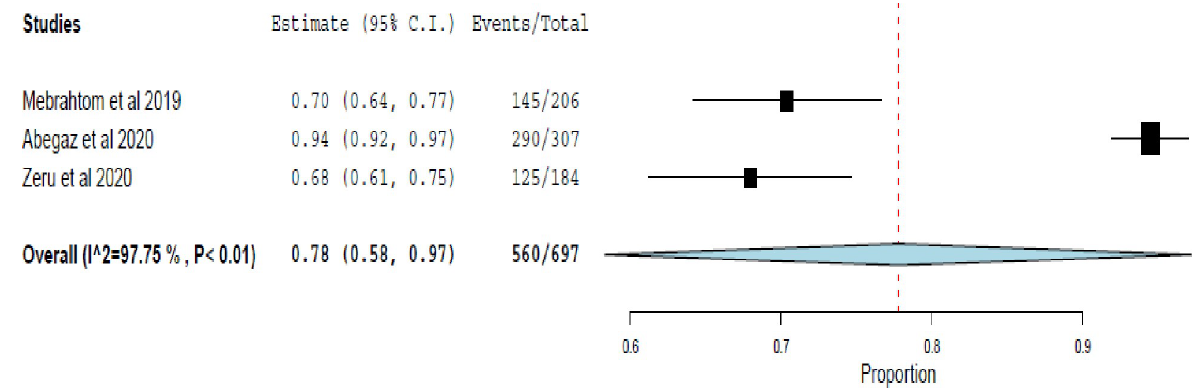
Fig 7. The rate of uncontrolled asthma assessed using the Asthma Control Test